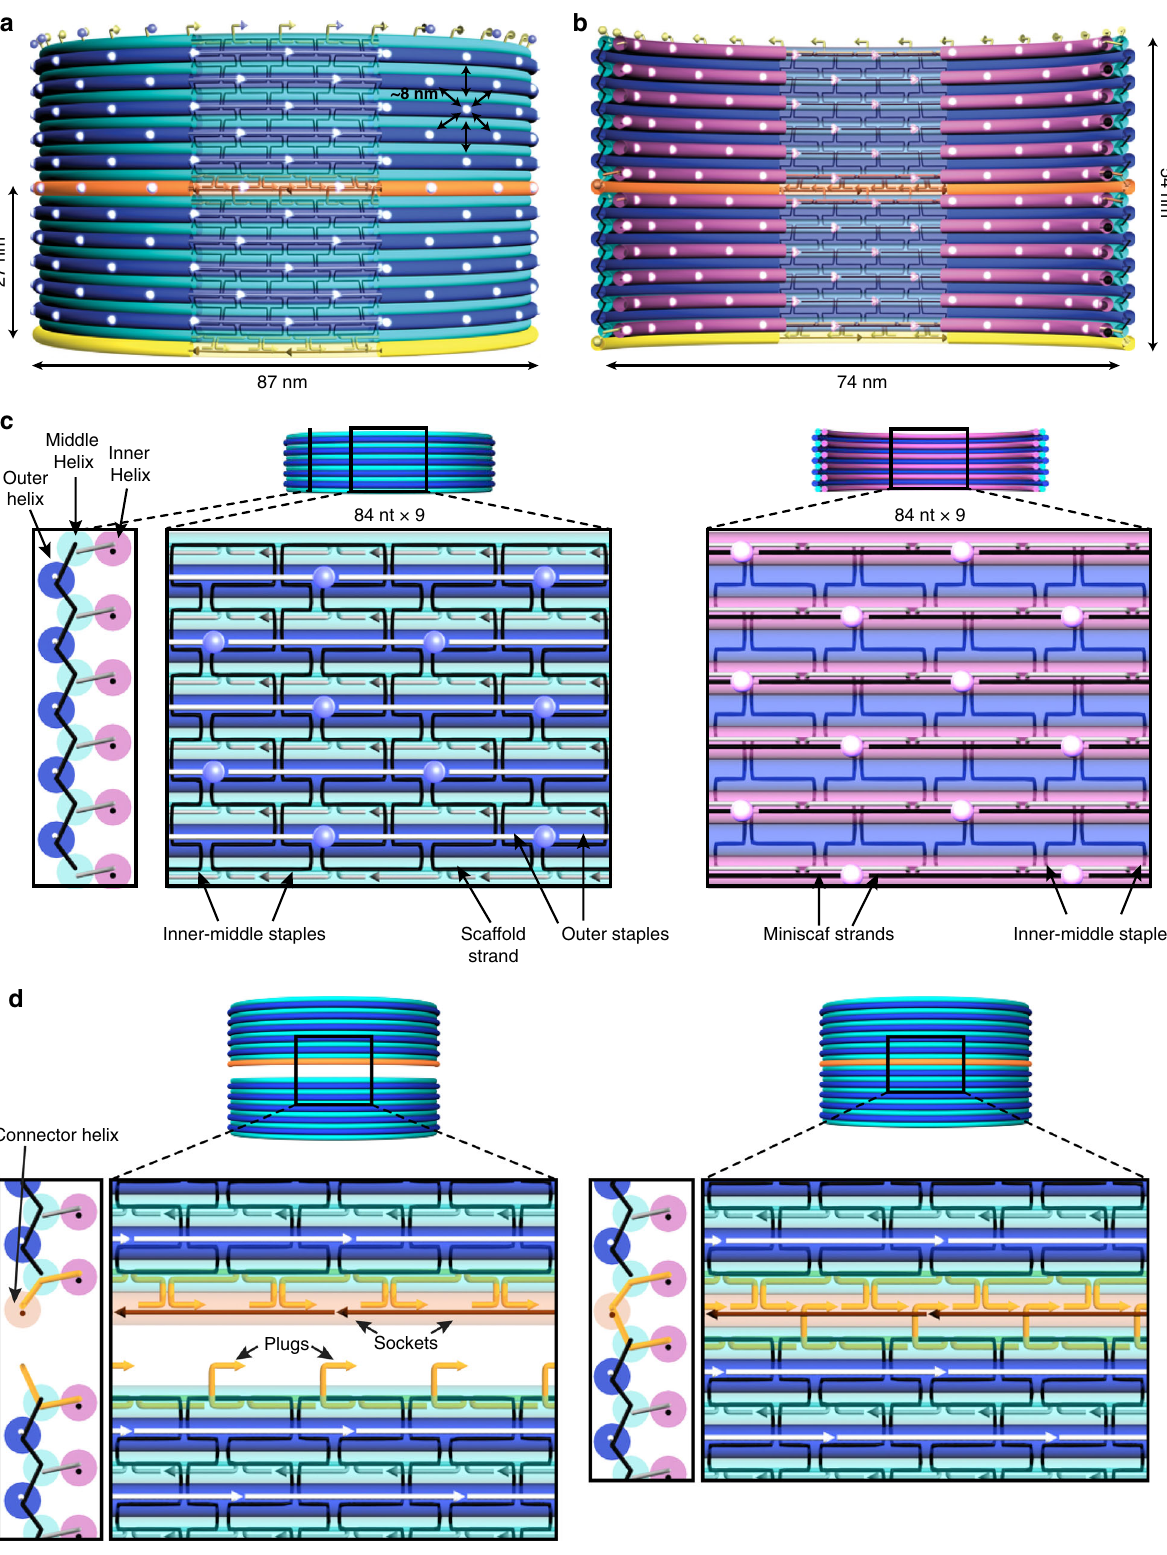
distances in Fig. 3 yielded DNA-barrel heights of 63, 33, 22 nm for 30, 60, 90-nm barrels, respectively. Comparing designed (D) height versus DNA-PAINT (P) height in sideways-oriented particles versus TEM (T) height in sideways-oriented particles, we measured the following in nanometers: 30-nm barrel (D 62, P